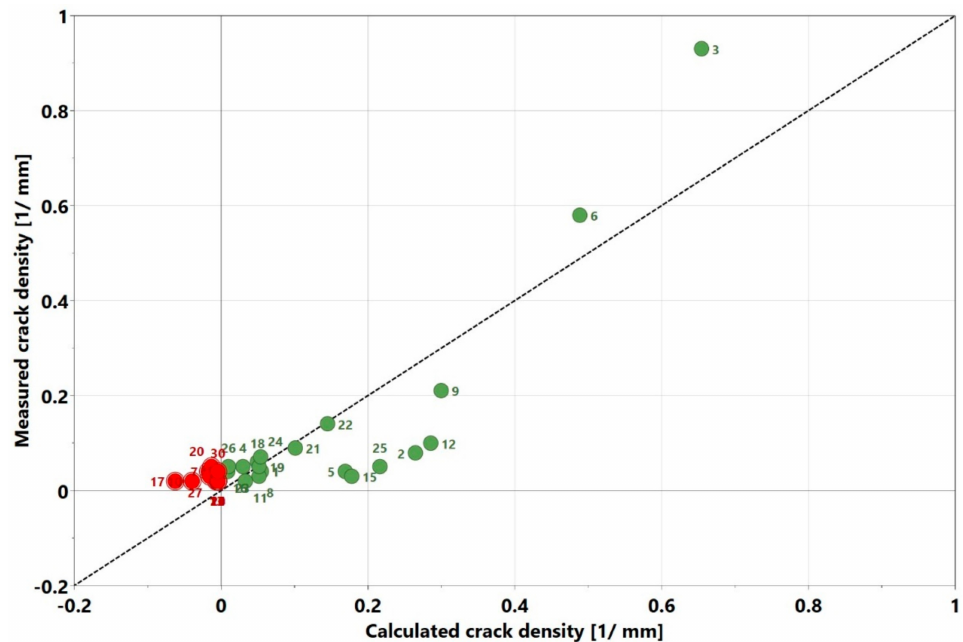
Figure14. Comparisonofexperimentallymeasuredcrackdensitywithcalculatedvaluesfromregression model (red data points indicate calculated point with negative values of crack density).